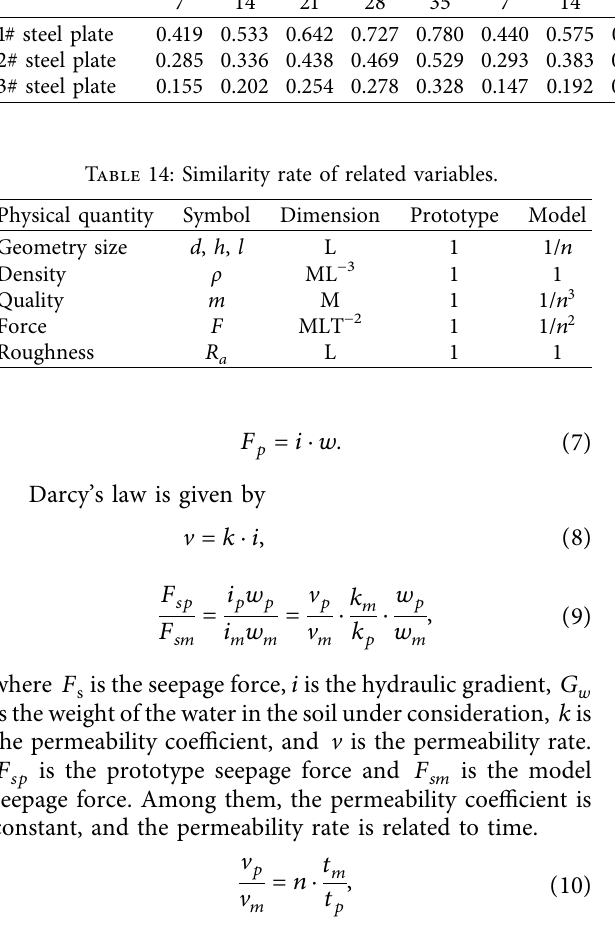
Table 13: Verification analysis of the pull-out force of underwater (mixed) silt. Measured value of blockage pull- Blocked objects